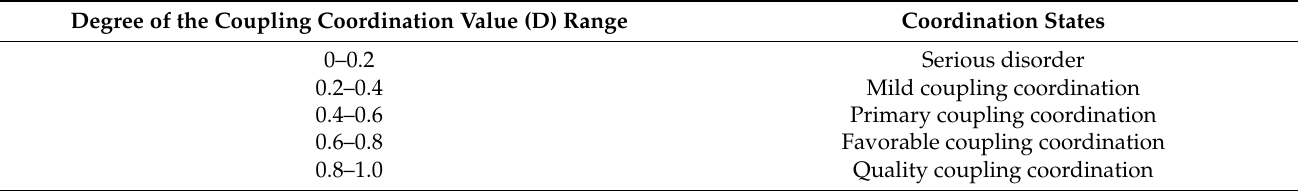
Table 5. Classification of coupled coordination